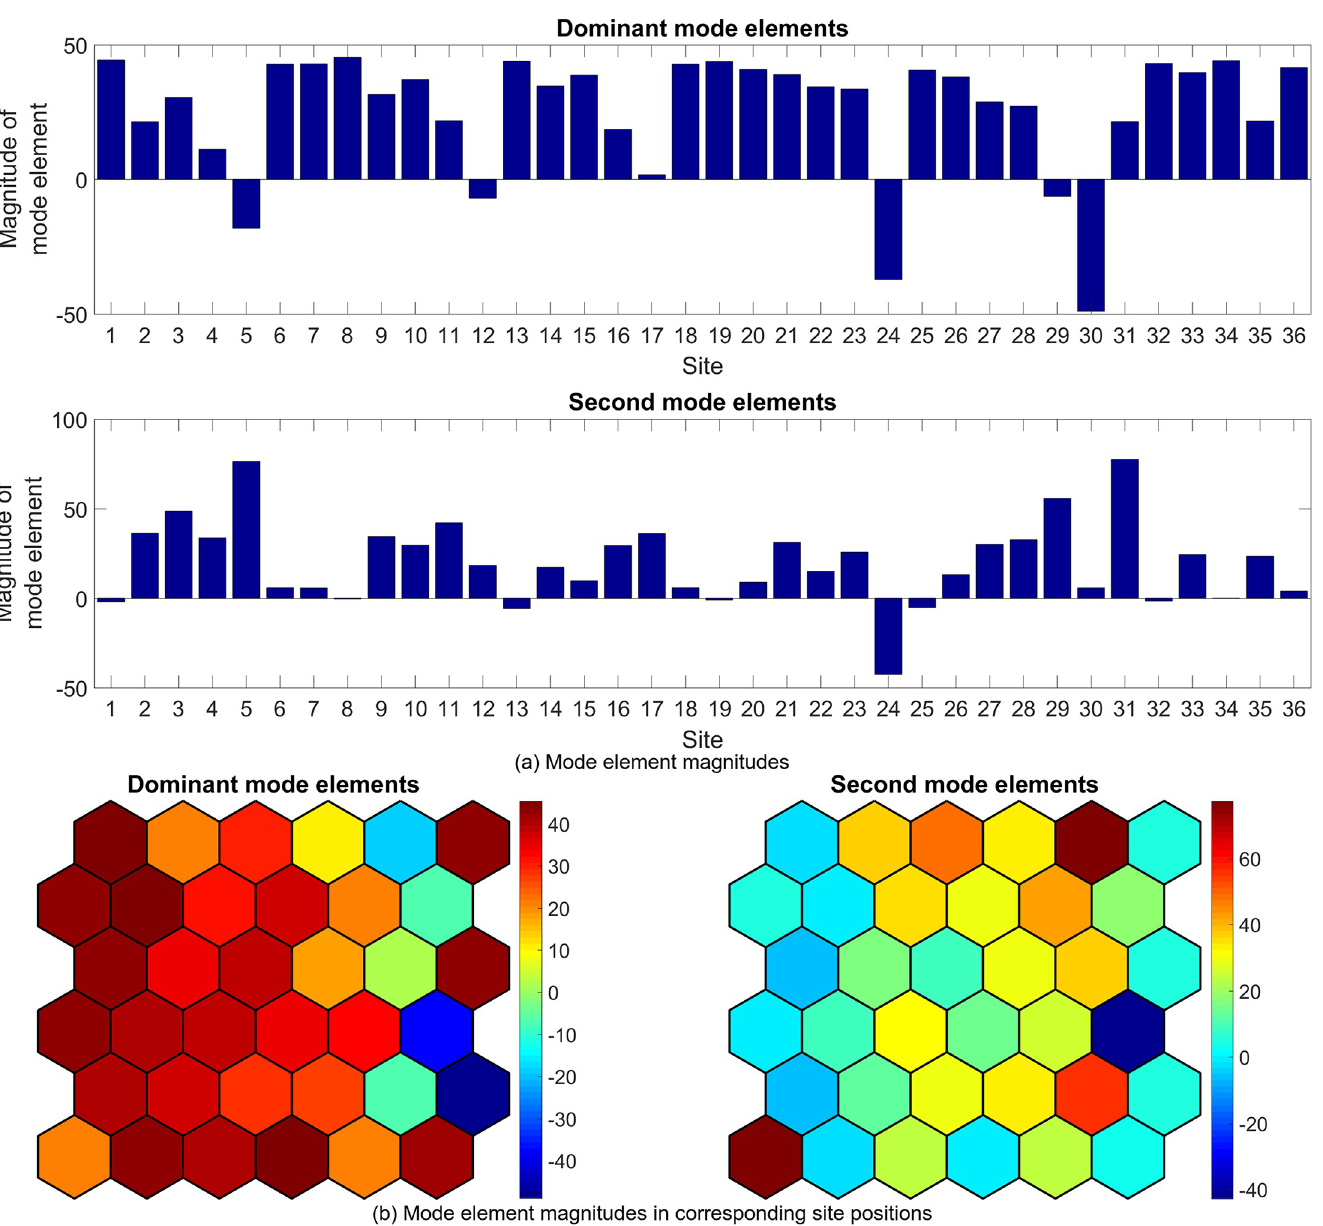
Fig 25. Example mode elements of the dominant and second modes from a single simulation for maximum site fuel value of 100 units, shown in bar graph form (a) and in the spatial positions of the corresponding sites (b). The dominant mode values approximate the mean site fuel values, while the second mode values show the degree to which site fuel values oscillate and/or undergo long-term